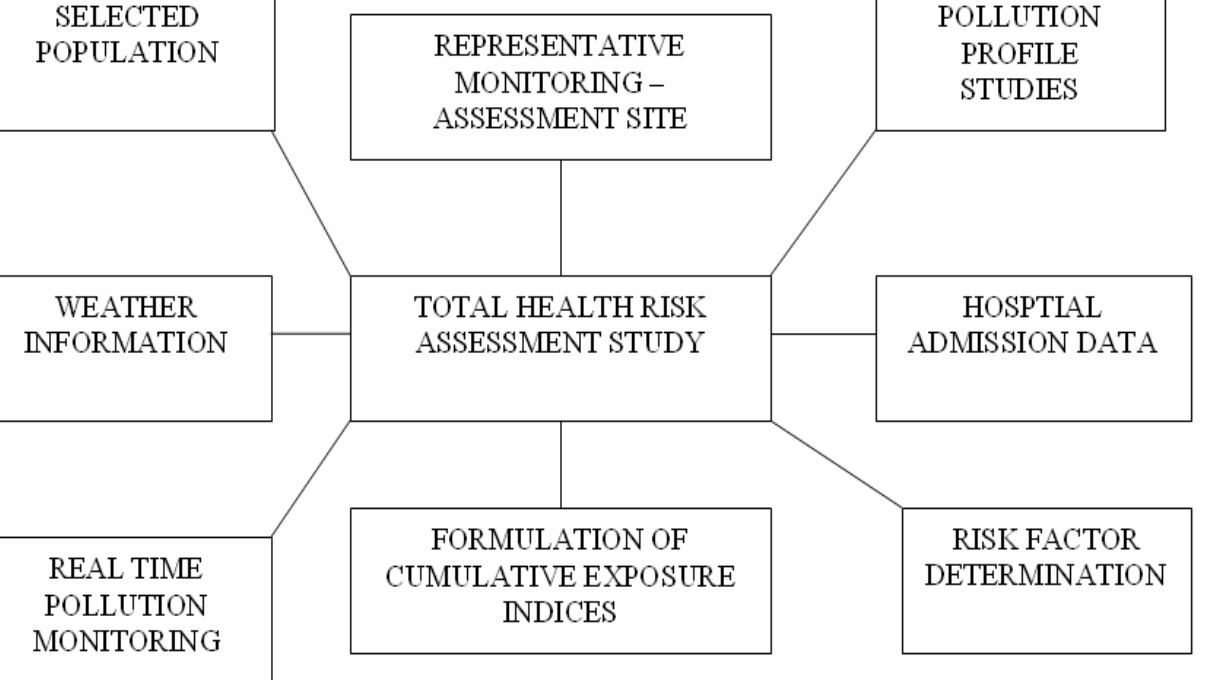
Figure 1: Broad methodological framework for total risk